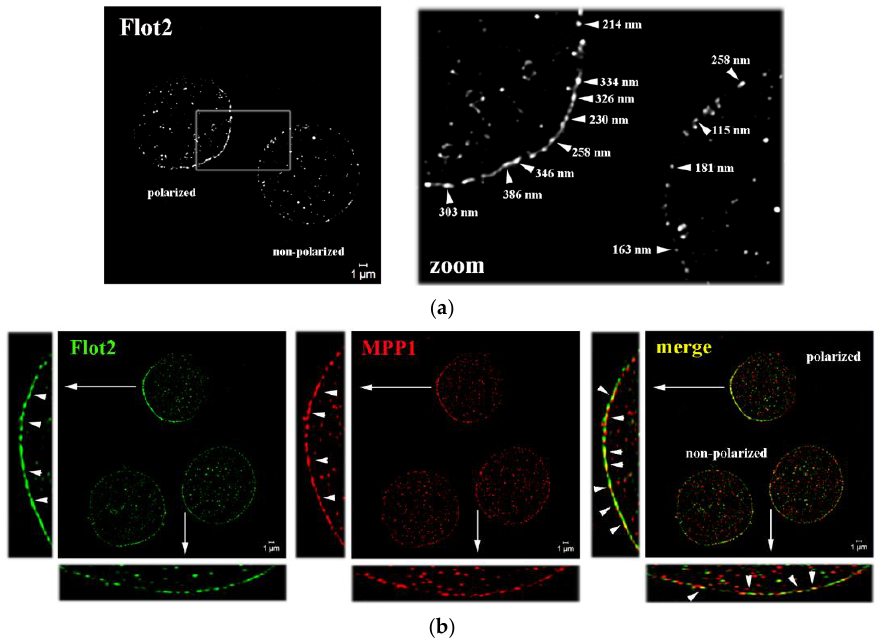
Figure 1. MPP1 forms both small nano- and large micrometer size complexes with flotillins in the PM of erythroid cells ( a ) Representative SIMˆ2 images showing organization of endogenous flotillin 2 (Flot2) in highly polarized preassembled caps (polarized cells) or small flotillin nanoclusters uniformly distributed along the PM (non-polarized cells) of control HEL cells (left). The blank rectangle corresponds to the zoomed region (right) of the selected area wheres the estimated sizes of flotillin complexes were indicated (also see Figure S1d). ( b ) Representative SIMˆ2 images showing co- localization of Flot2 and MPP1 in control HEL cells. Two types of MPP1-flotillin complexes are found, large polarized-micrometer size (in flotillin 2-caps) and small uniformly distributed nanometer-size clusters (in non-polarized cells). Size estimation is shown and described in Figure S3. Scale bar, 1 µ m. Images represent the central